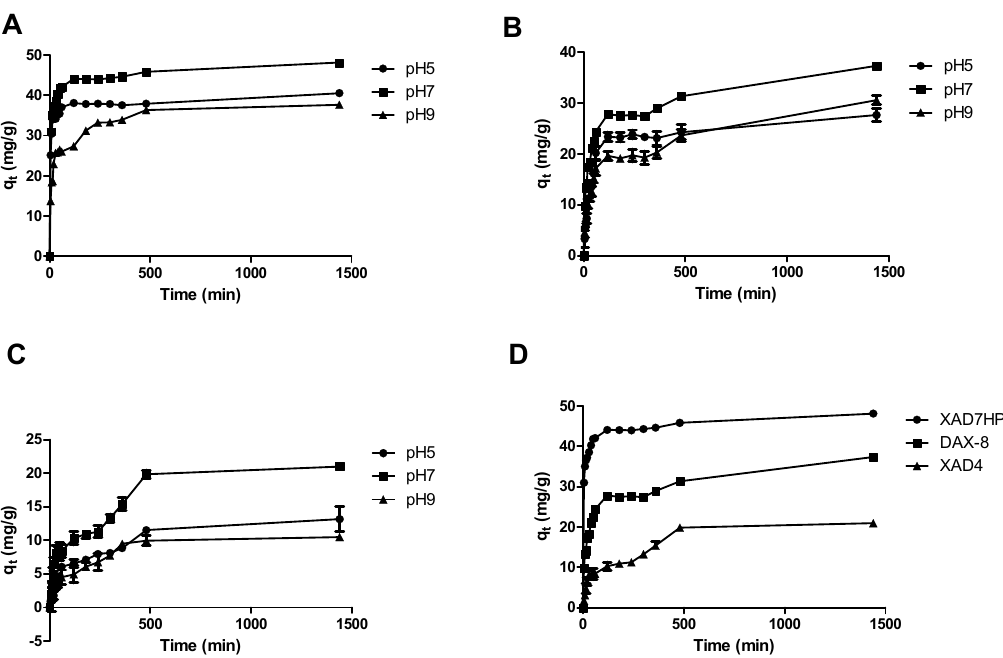
Figure 1. Time curves for adsorption kinetics of the selected MARs for OPL total flavonoids. ( A ) XAD7HP, ( B ) DAX-8, and ( C ) XAD4 at different pH; ( D ) comparison of the time curves for the different MARs at pH 7.